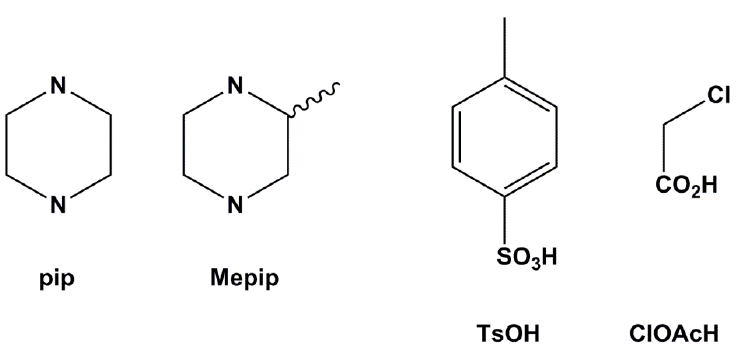
Figure 2. The bases and acids used in this